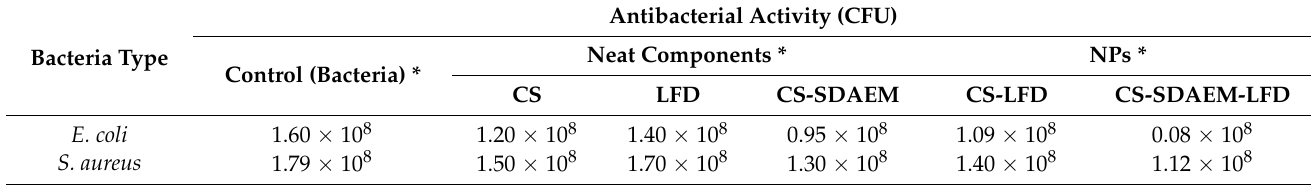
Table 2. Antibacterial activity of the pure CS, LFD, and the prepared NPs expressed in terms of colony-forming units (CFU) using E. coli and S. aureus